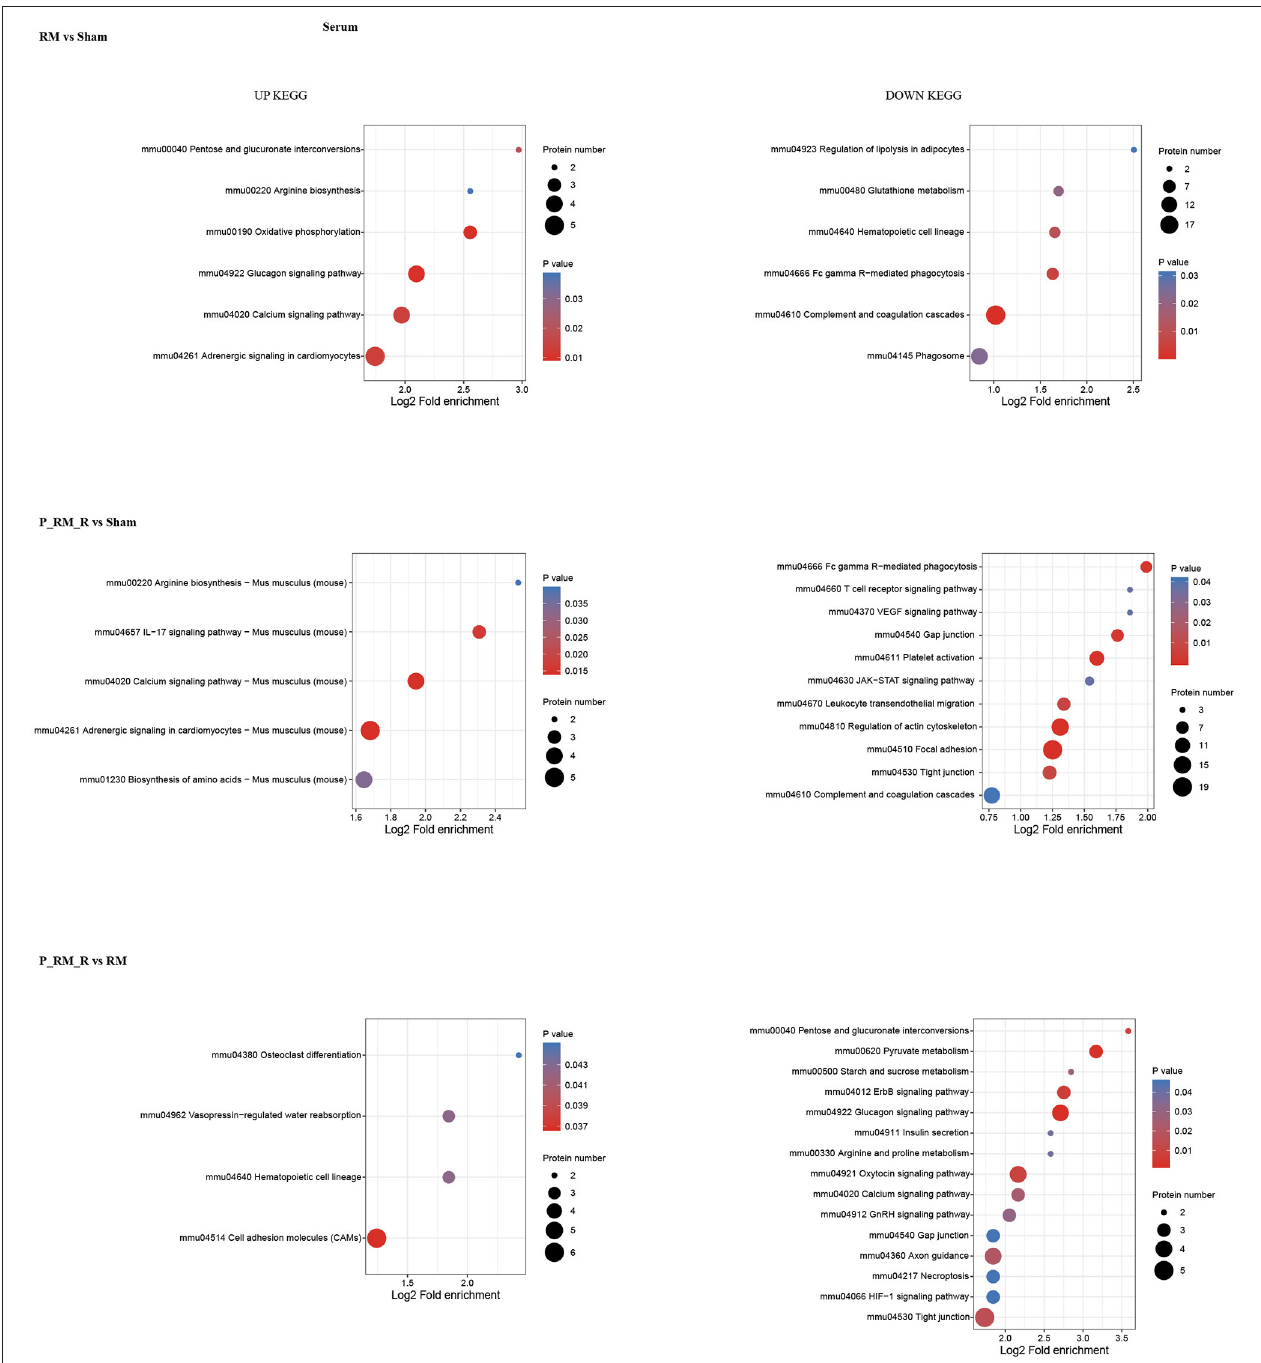
FIGURE 4 | KEGG pathway enrichment of proteins in serum. RM, rhabdomyolysis; P_RM_R, the mouse in the parabiosis model administered glycerol; P_RM_S, the other mouse in the parabiosis model supplying the exogenous biological renal support.